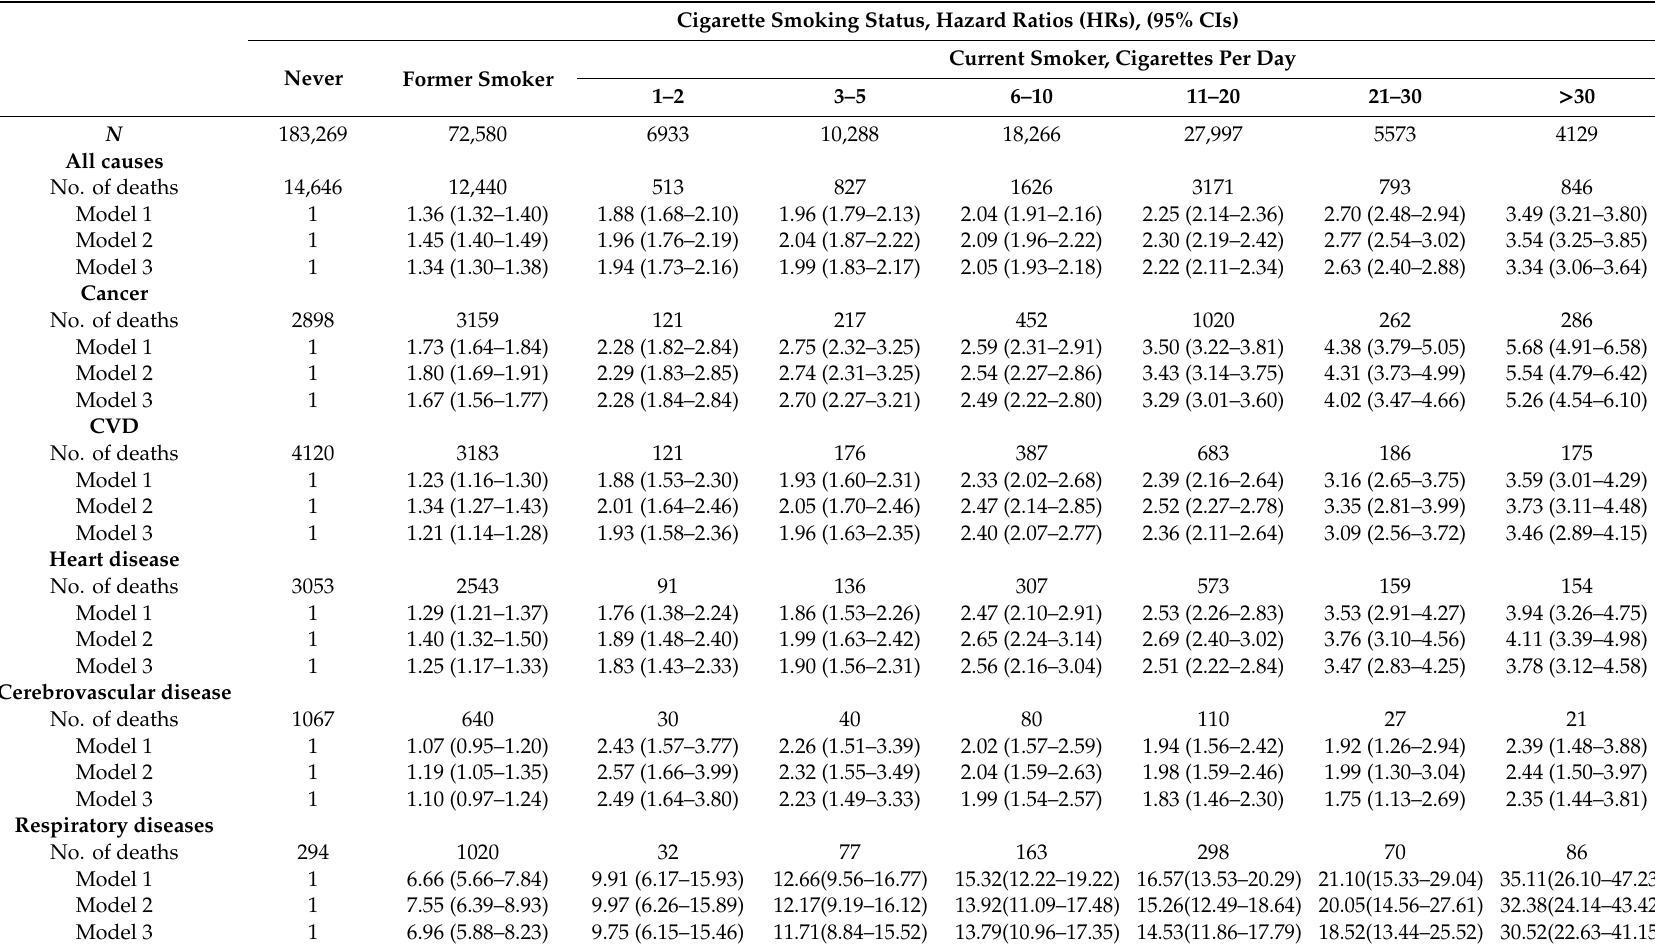
Table 2. Association of cigarette smoking status with risk of all-cause and cause-specific